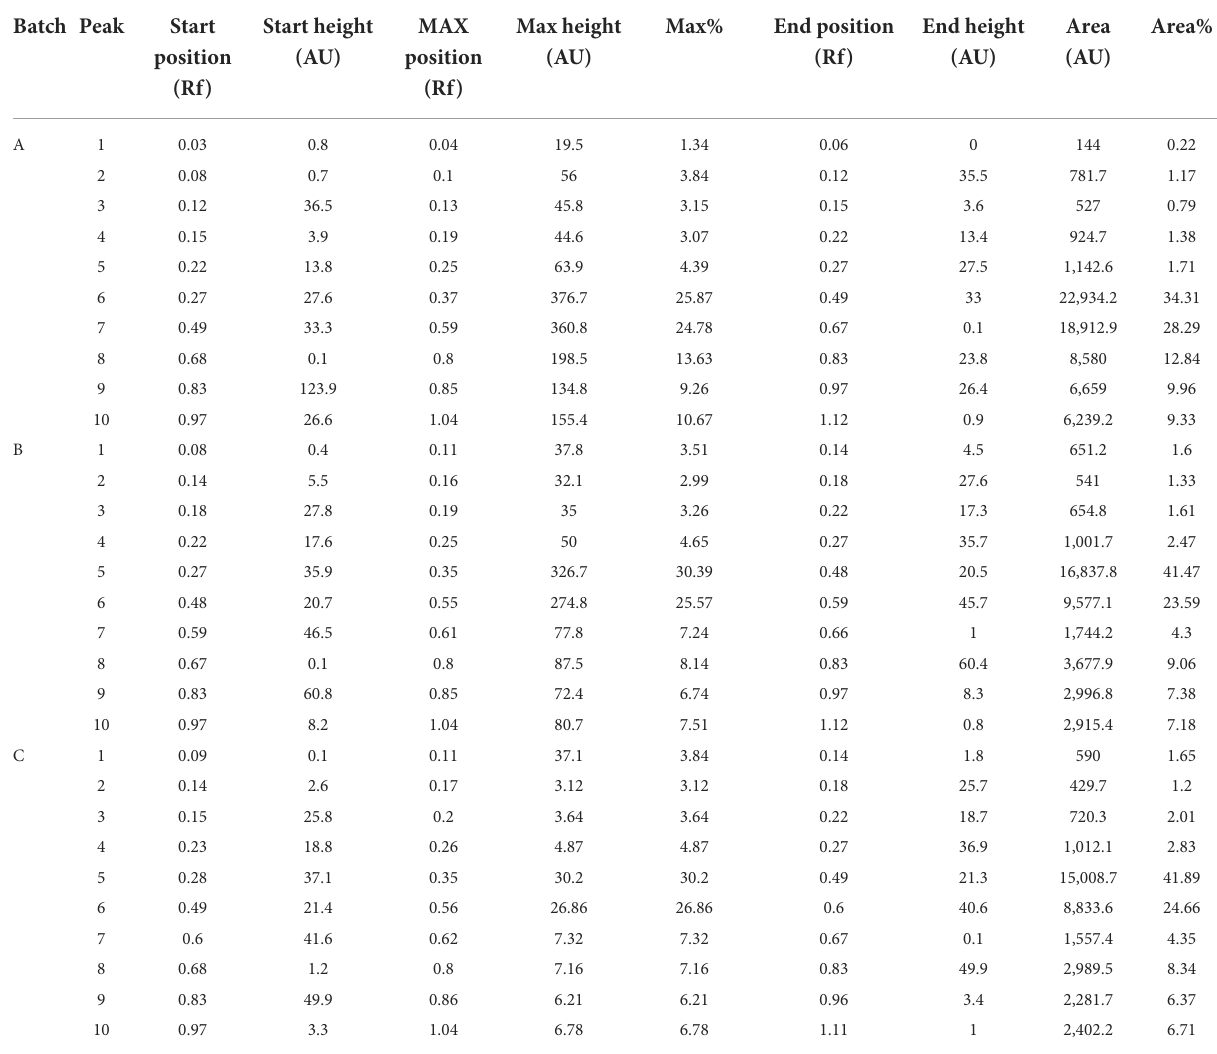
TABLE 5 HPTLC data—Batch A, B, and C of TC .